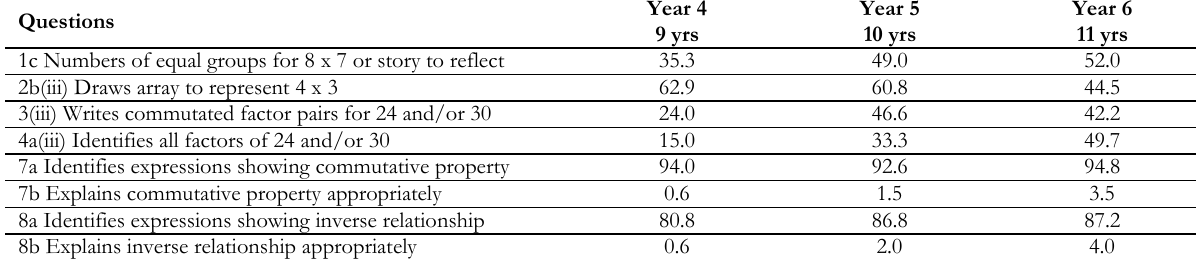
Table 3. Percentages of students by age/year groups recording correct responses to the eight questions